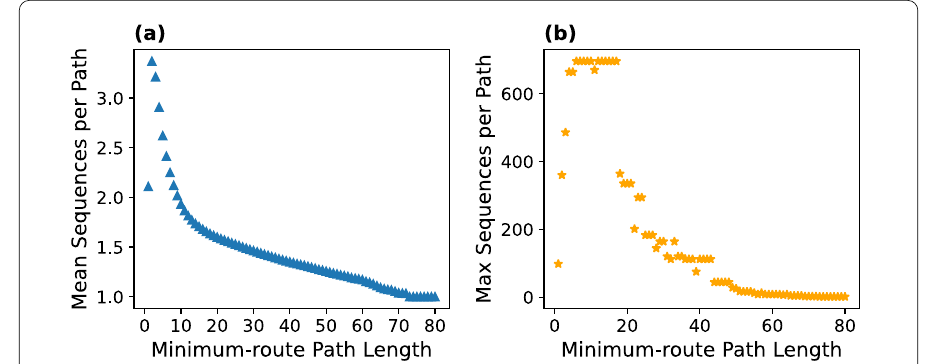
Figure 6 Many route sequences realize the same paths. Minimum-route path length (horizontal) against the ( a ) mean and ( b ) maximum number of route sequences for minimum-route paths of that length. The mean number of route sequences per path is low (less than 4) across all path lengths, but maximums reach as high as 700 sequences realizing a single